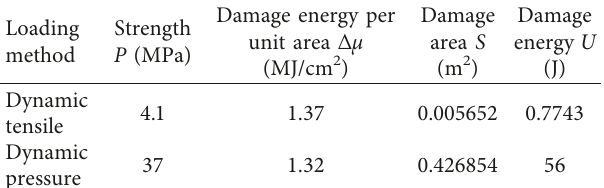
Table 2: The damage area and damage energy for samples sub- jected to dynamic pressure and dynamic tensile